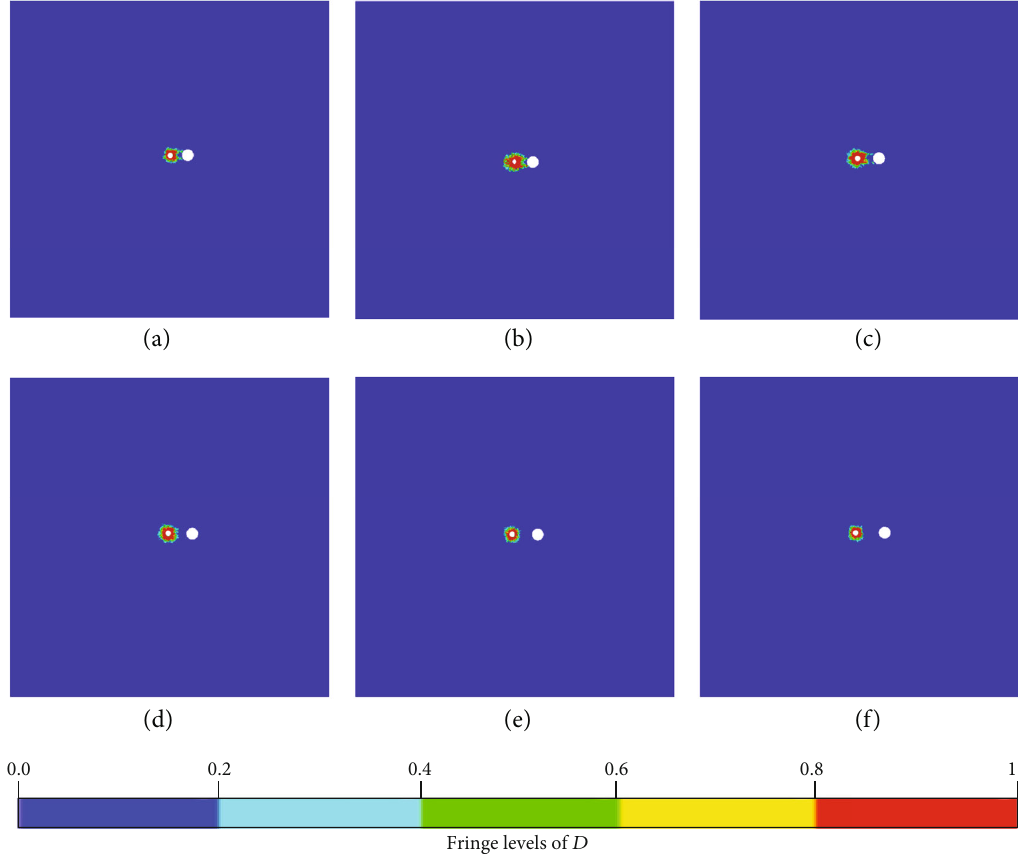
Figure 4: Compression damage of prime cut blasting under di ff erent burdens: (a) scheme 1, (b) scheme 2, (c) scheme 3, (d) scheme 4, (e) scheme 5, and (f) scheme